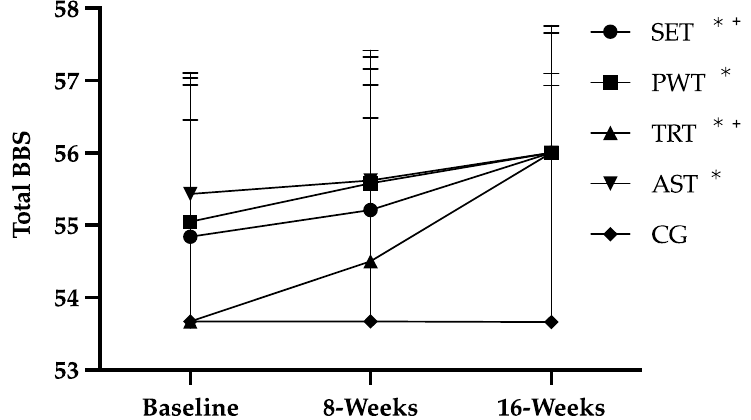
Figure 1. Effects of RT on balance of older women; traditional resistance training (TRT); strength endurance training (SET); power training (PWT); and absolute strength training (AST); total Berg balance scale score (Total BBS); * p < 0.05, 16 weeks vs. Baseline; + p < 0.05, 8 weeks vs. Baseline. Table 3. RT-type effects in PA and QoL. Baseline vs. 16-Week Group Baseline 8 Week 16 Week p